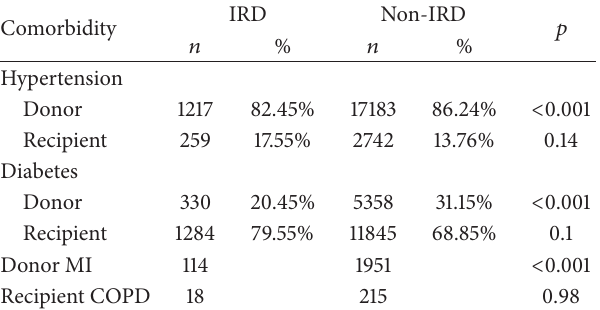
Table 2: Donor and recipient comorbidities.